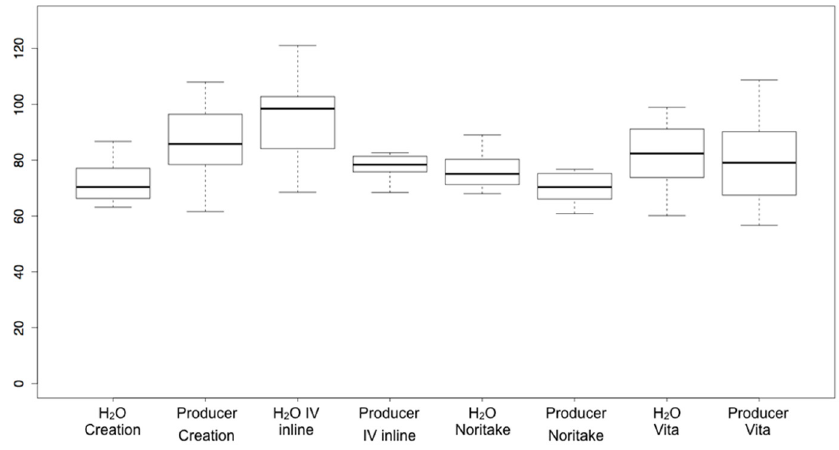
Figure 1. Boxplot-best of the groups CR, IV, NR, and VT, mixed with H 2 O or their corresponding modeling liquids.